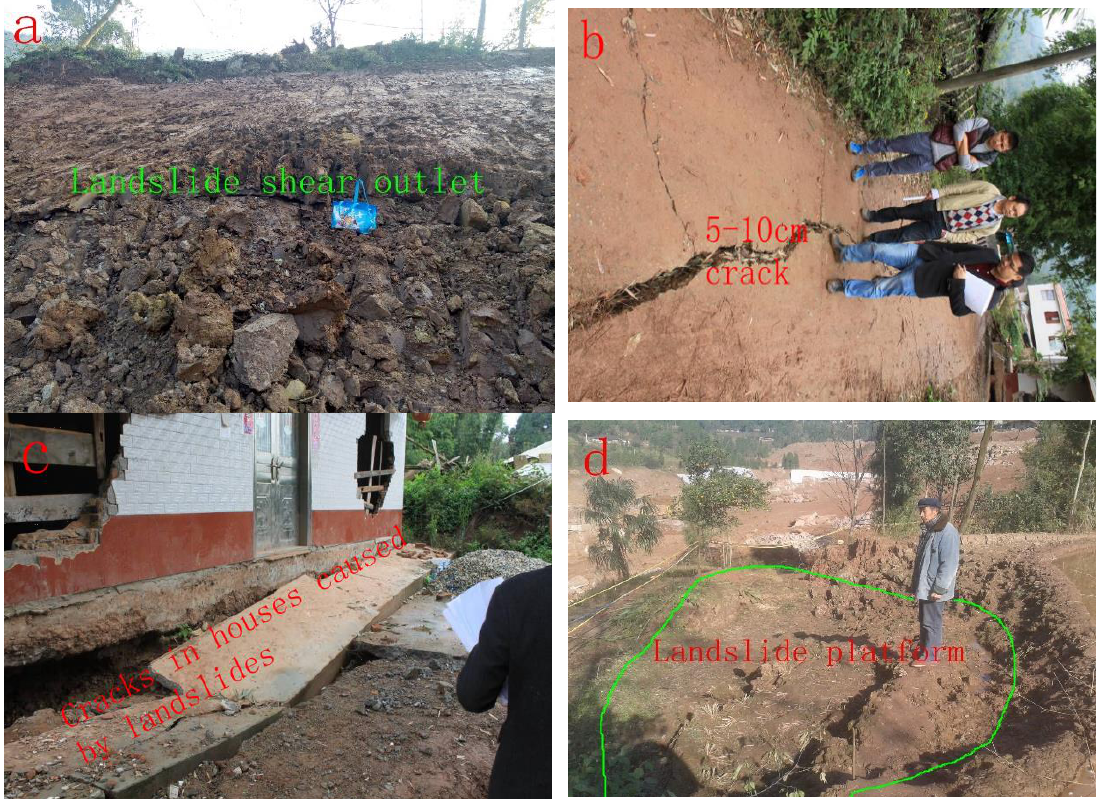
Figure 4. ( a ) Shear outlet in front of landslide, ( b ) rural road cracks on the back of the landslide, ( c ) cracks in the building foundation on the boundary of the landslide, ( d ) landslide platform on slide body.